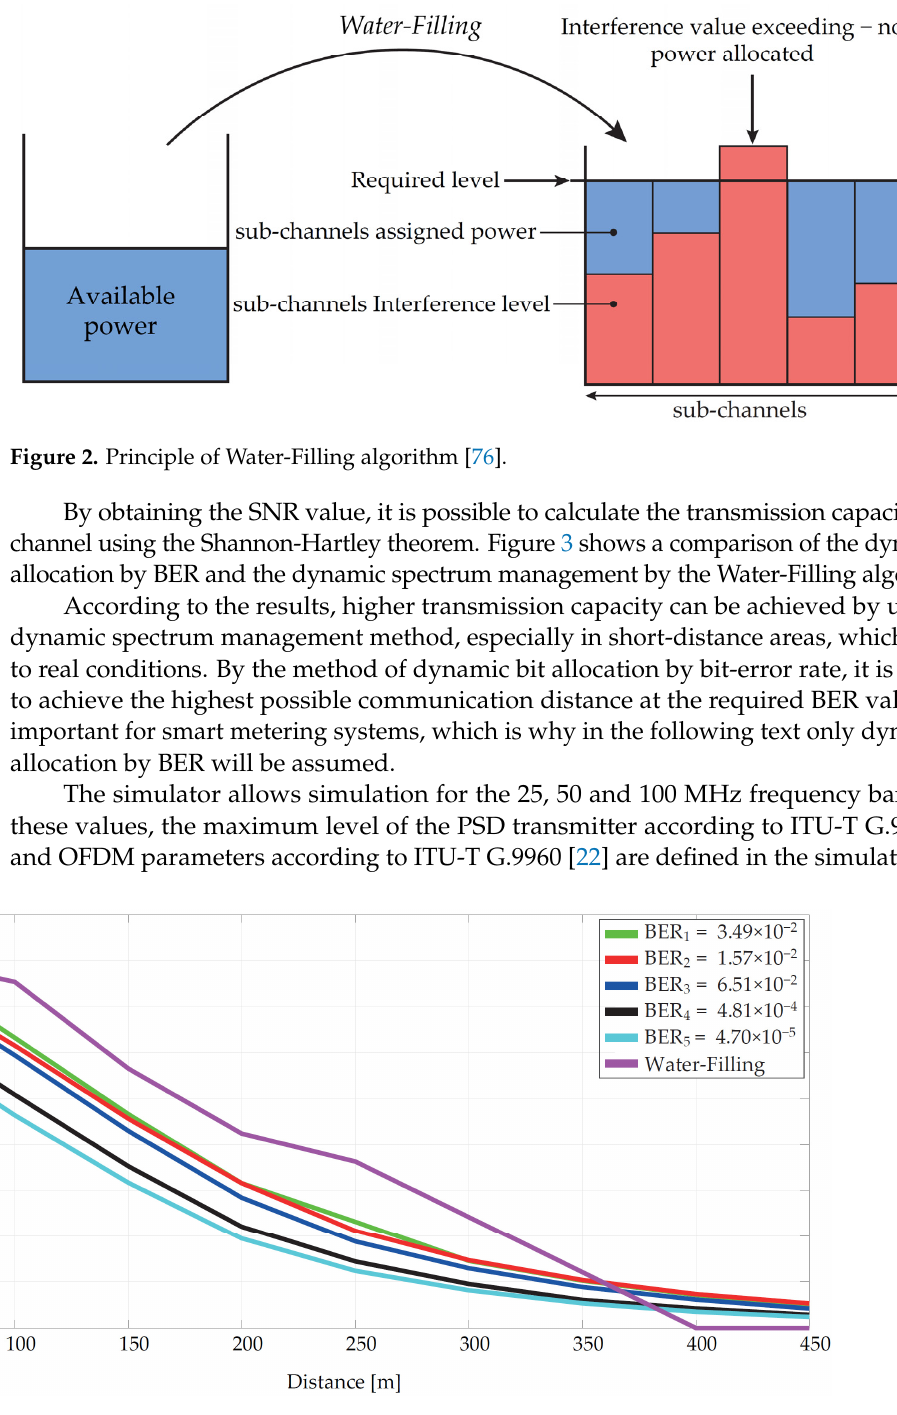
Figure 3. Dependence of transmission capacity on distance for different BER values with the method of dynamic bit allocation by bite-error rate and dynamic spectrum management by the Water-Filling algorithm (purple line).